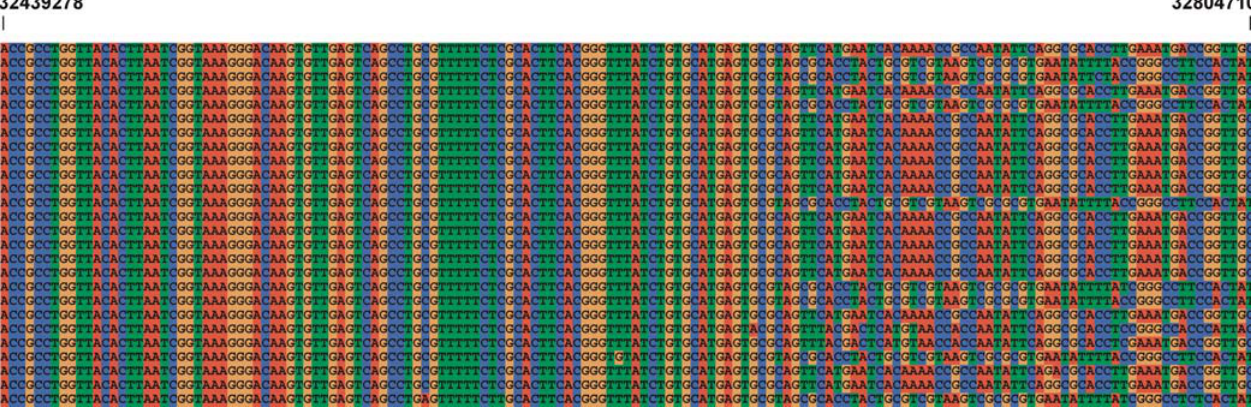
Figure 3. Haplotype Alignment of the Region Presenting Differing Variation Rates The alignment covers the centromeric side of the DR–DQ 158-kb DNA segment (left half, low variation) and the adjacent DNA segment (increased variation). Coordinates refer to Chromosome 6 build NCBI35. Rows represent the allelic state for 26 single chromosomes with the same DRB1*1501-